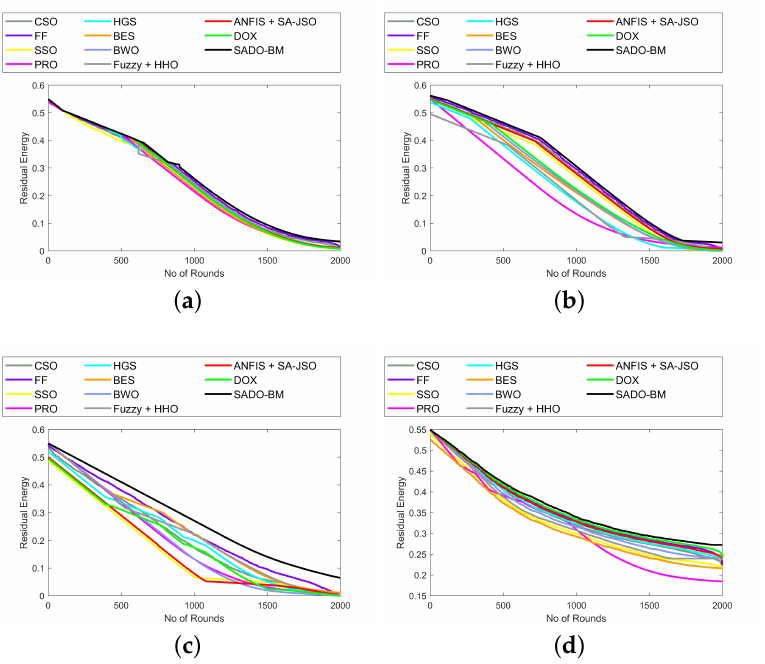
Figure 7. Energy analysis of SADO-BM over other models for node counts ( a ) 100, ( b ) 250 ( c ) 750, and